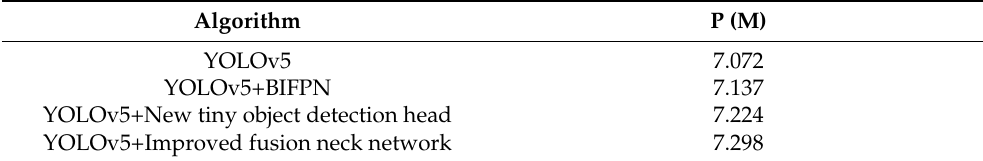
Table 7. The parameters of the above improved neck network.